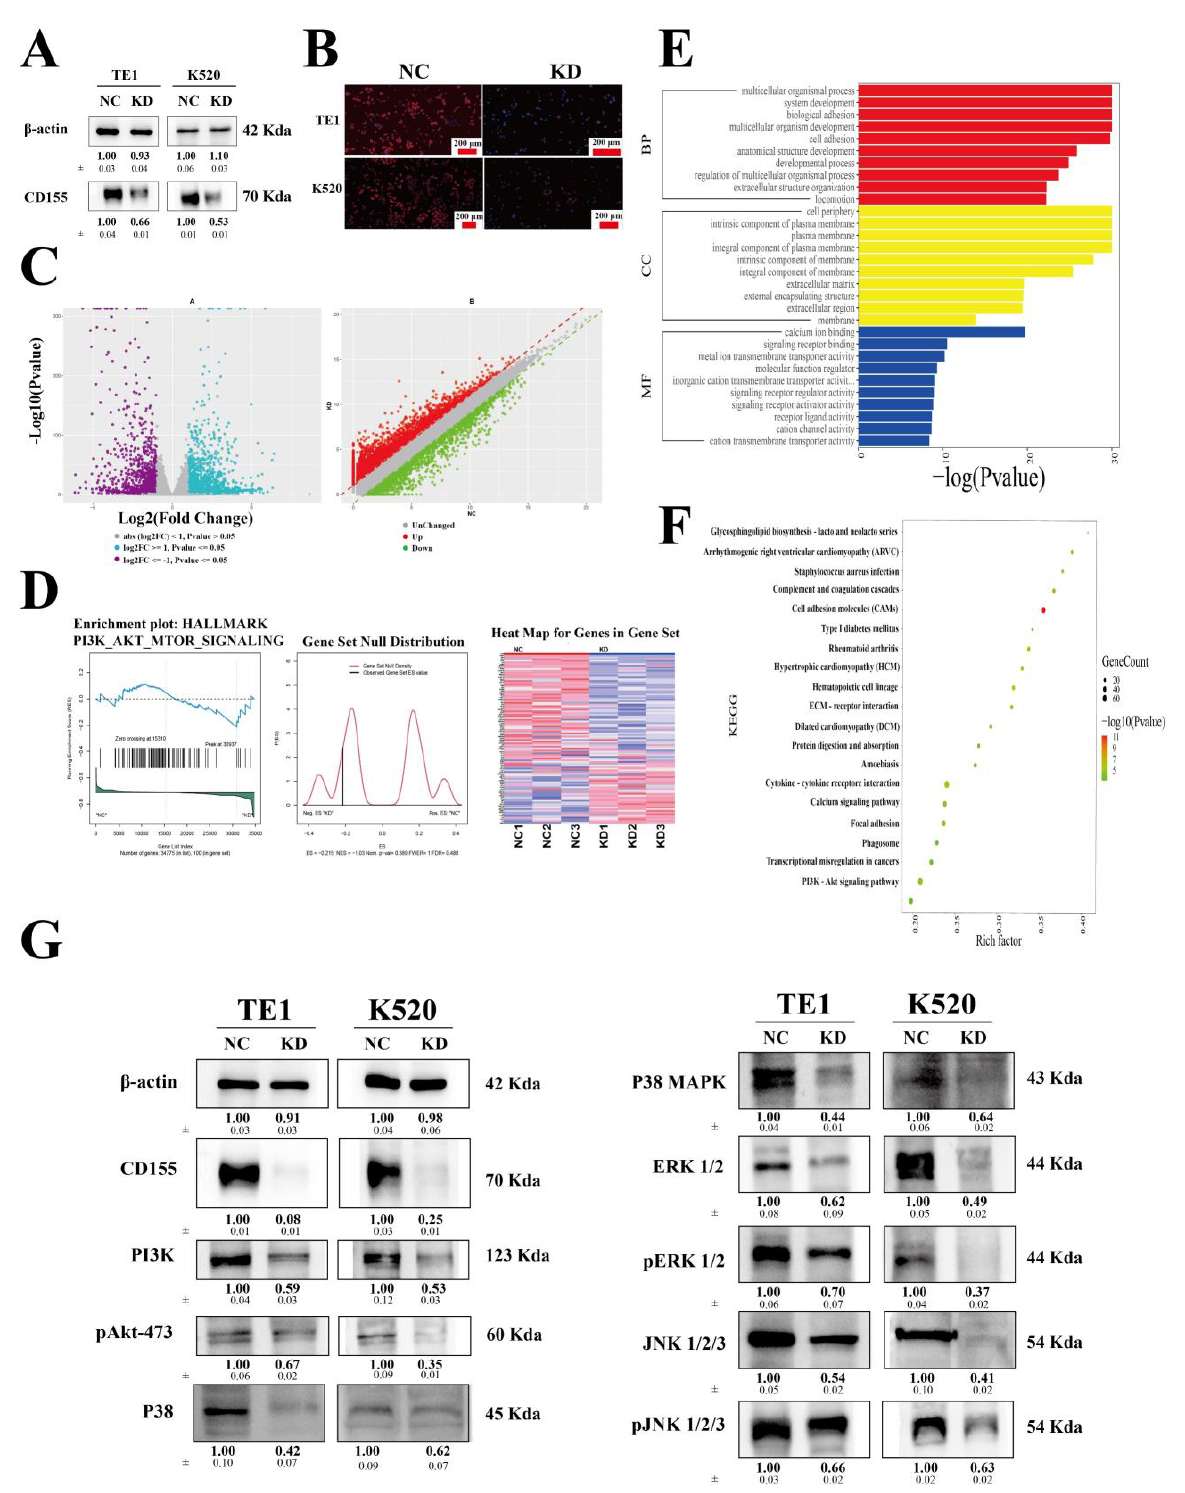
Figure 7. CD155 can regulate the PI3K/Akt and MAPK pathways in ESCA. ( A ) Western blot and ( B ) immunofluorescence data confirmed the decreased expression of CD155 in ESCA cells. ( C ) RNA sequencing of these cells and a respective ( D ) GSEA analyses were conducted, followed by ( E ) GO and ( F ) KEGG. KEGG and GSEA analyses both indicated that the CD155-related differentially expressed genes were mainly associated with the PI3K/Akt and MAPK signaling pathways. ( G ) The two signaling pathways related to CD155 were verified with Western blotting.The original WB Blots of subfigure ( A ) is Figure S5. The original WB Blots of subfigure ( G ) are Figure S6.